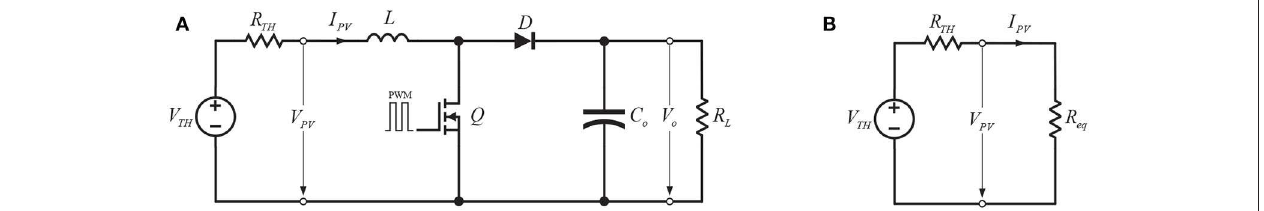
FIGURE 4 | (A) PV source’s equivalent Thevenin circuit with MPPT boost converter; (B) The equivalent impedance of MPPT boost converter in connected with PV source.